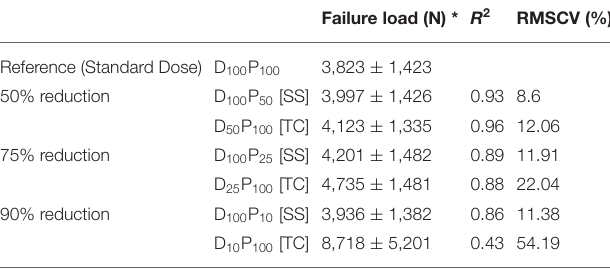
TABLE 2 | Mean FE-predicted failure load, standard deviation, coefficient of correlation and RMSCV values for all the radiation dose levels.